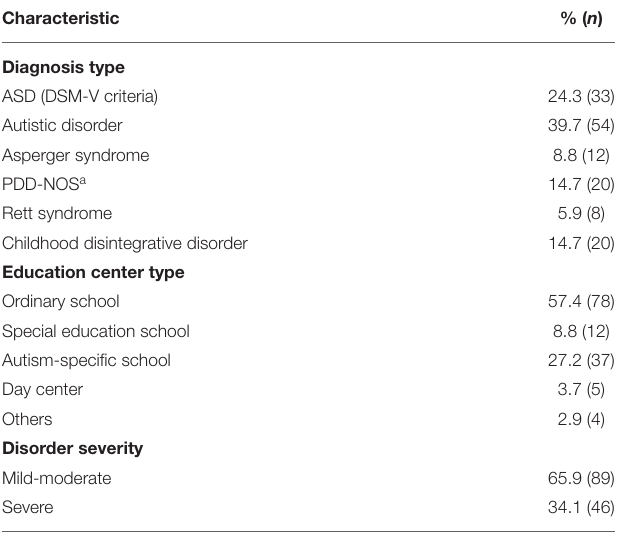
TABLE 2 | Descriptive characteristics of individuals with autism.